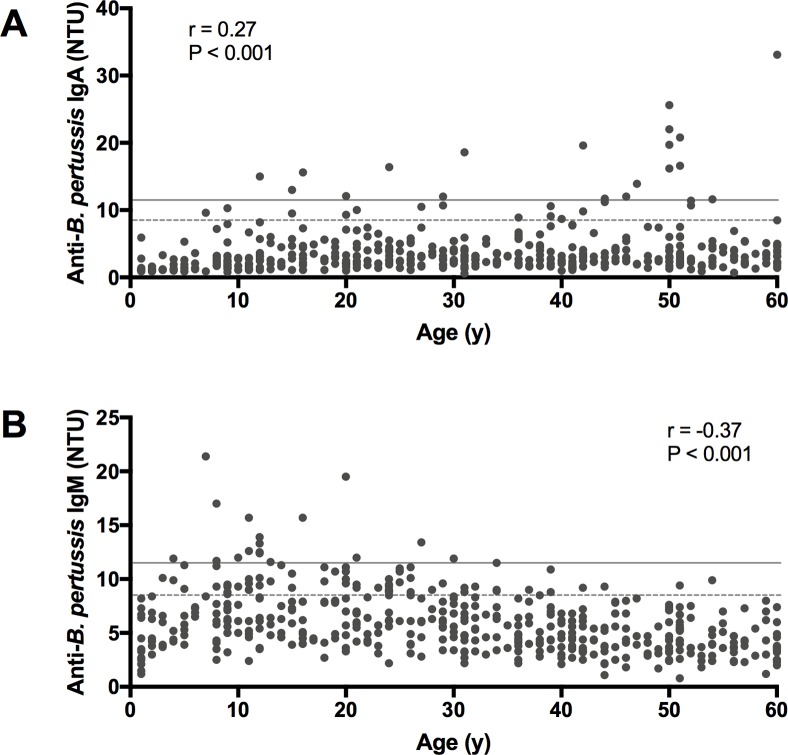
Seroprevalence of anti-B. pertussis IgA and IgM in healthy Japanese donors.(A) anti-B. pertussis IgA, (B) anti-B. pertussis IgM; Spearman correlation coefficients and P values are given in the panels. The arbitrary cut-off values for positive and indeterminate titer values are indicated by straight gray lines (11.5 NTU) and dashed lines (8.5 NTU), respectively.